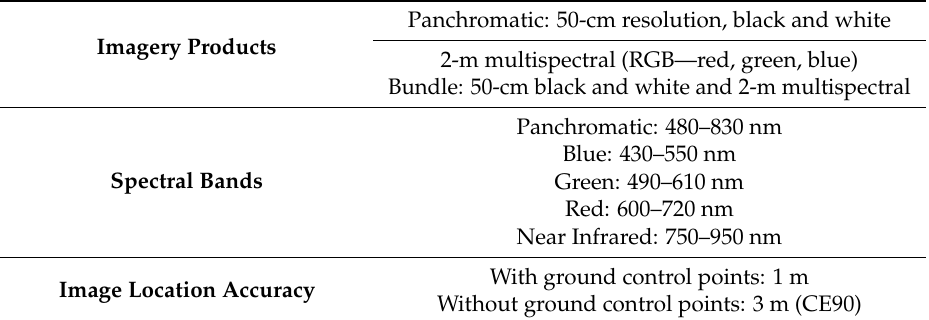
Table 1. Pleiades-1A satellite sensor characteristics